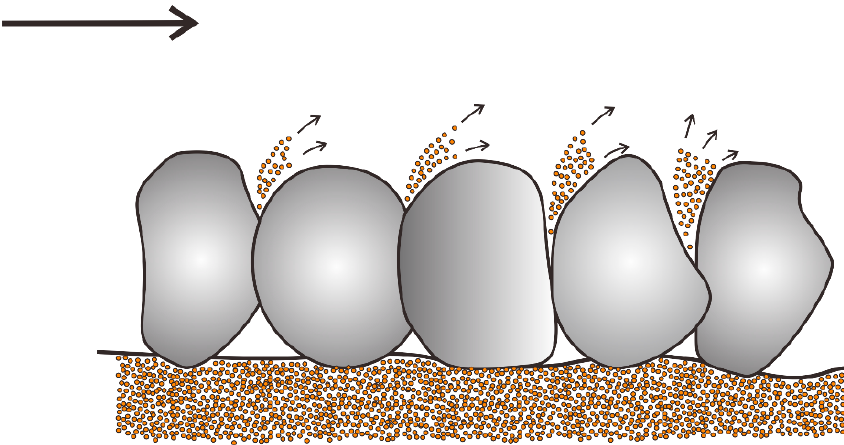
Figure 3. Definition sketch for the suction removal of sediments from armor blocks (reproduced from [9]).